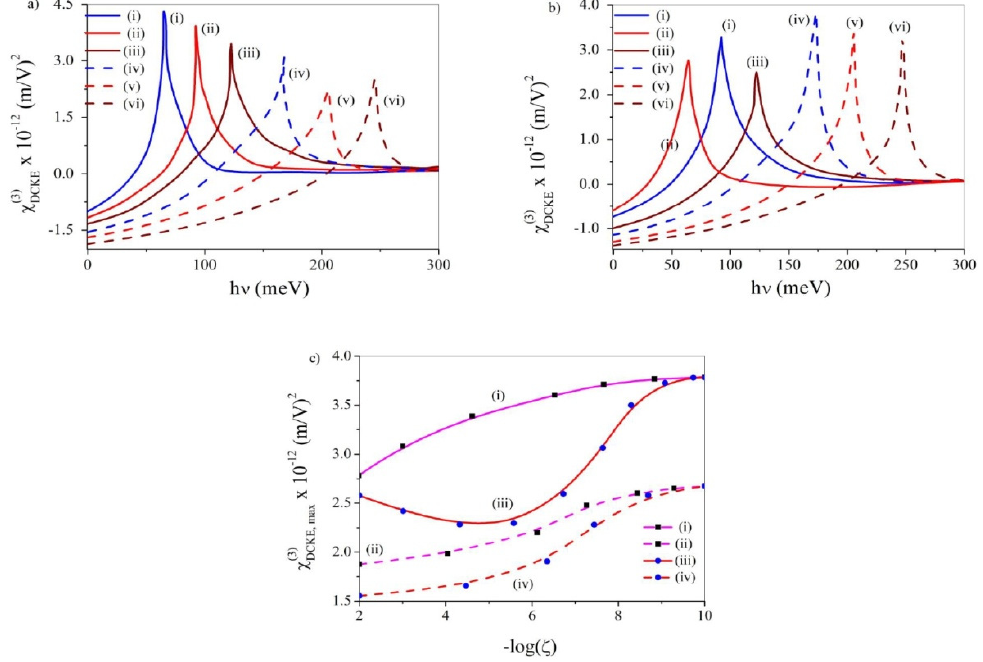
Figure 14. DCKE vs. h υ diagrams with ( a ) OPA and ( b ) EPA. In these diagrams (i) ADWN and ζ = 10 − 10 , (ii) ADWN and ζ = 10 − 6 , (iii) ADWN and ζ = 10 − 2 , (iv) MLWN and ζ = 10 − 10 , (v) MLWN and ζ = 10 − 6 , (vi) MLWN and ζ = 10 − 2 . ( c ) Depiction of DCKE peak vs. − log( ζ ): (i) with ADWN and OPA, (ii) with ADWN and EPA, (iii) with MLWN and OPA and (iv) with MLWN and EPA. With EPA and under applied ADWN, the DCKE peaks depict initial red-shift up to ζ ~ 10 − 6 followed by a blue-shift as ζ increases further. However, under applied MLWN, the DCKE peaks depict uniform blue-shift as ζ increases. The peak altitude, on the other hand, undergoes steady decline with an increase in ζ both under applied ADWN and MLWN.